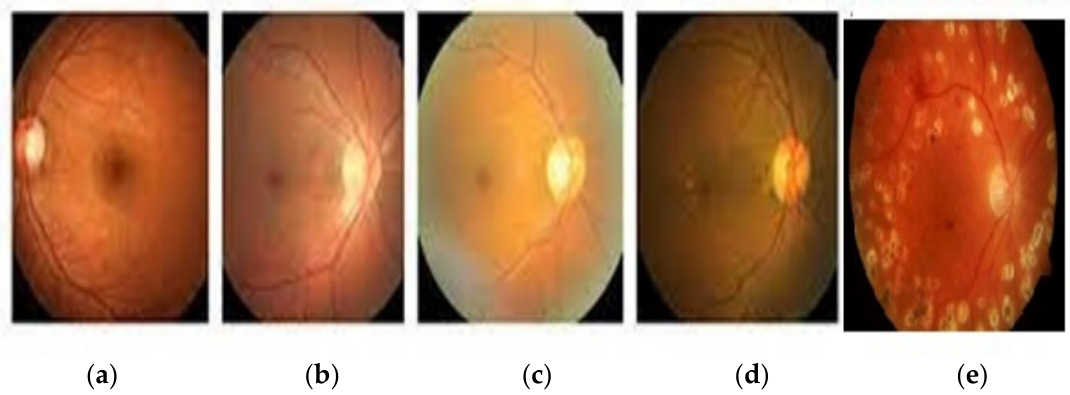
Figure 1. ( a ) Class 0 (No DR), ( b ) Class 1 (mild nonproliferative retinopathy), ( c ) Class 2 (moderate nonproliferative retinopathy), ( d ) Class 3 (severe nonproliferative retinopathy), and ( e ) Class 4 (proliferative DR).